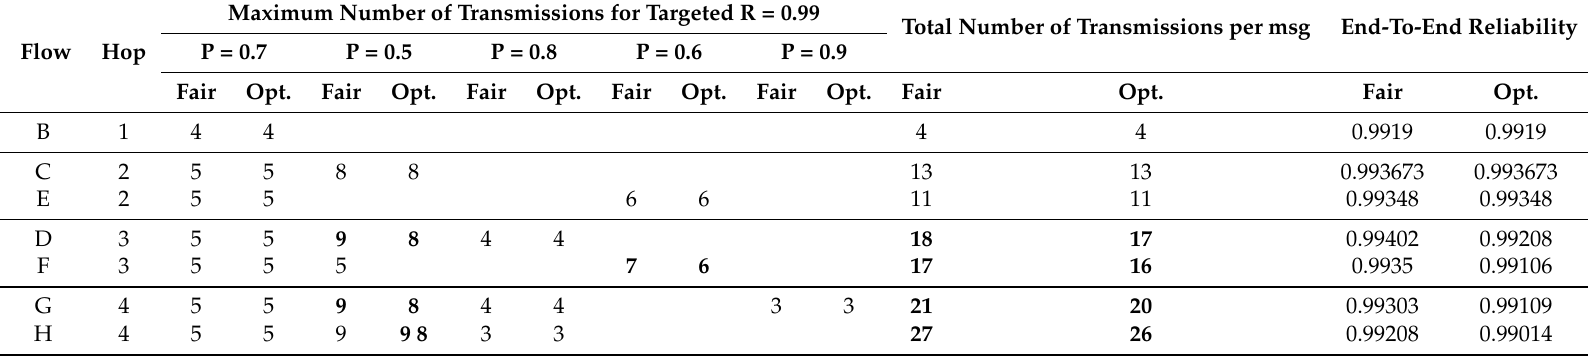
Table 4. Comparison of MFair and MOpt for a targeted end-to-end reliability R = 0.99 on seven flows. Maximum Number of Transmissions for Targeted R =